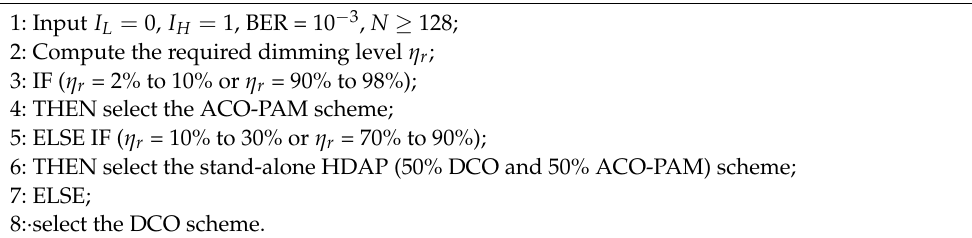
Algorithm 1 Pseudocode for switching method between ACO-PAM, HDAP, and